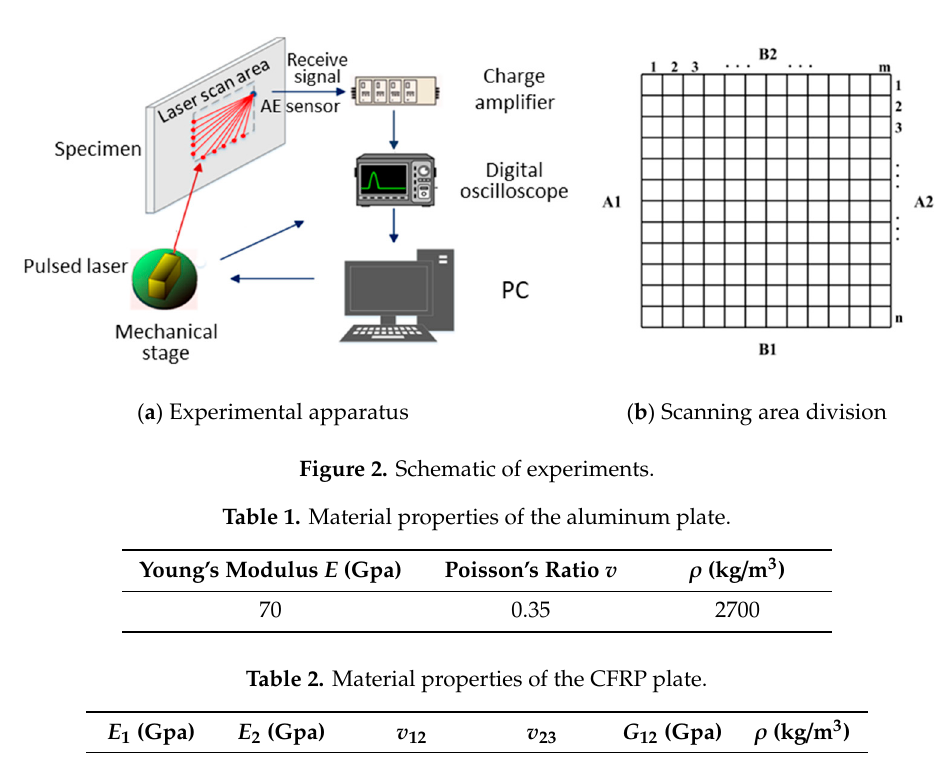
Figure 2. Schematic of experiments.